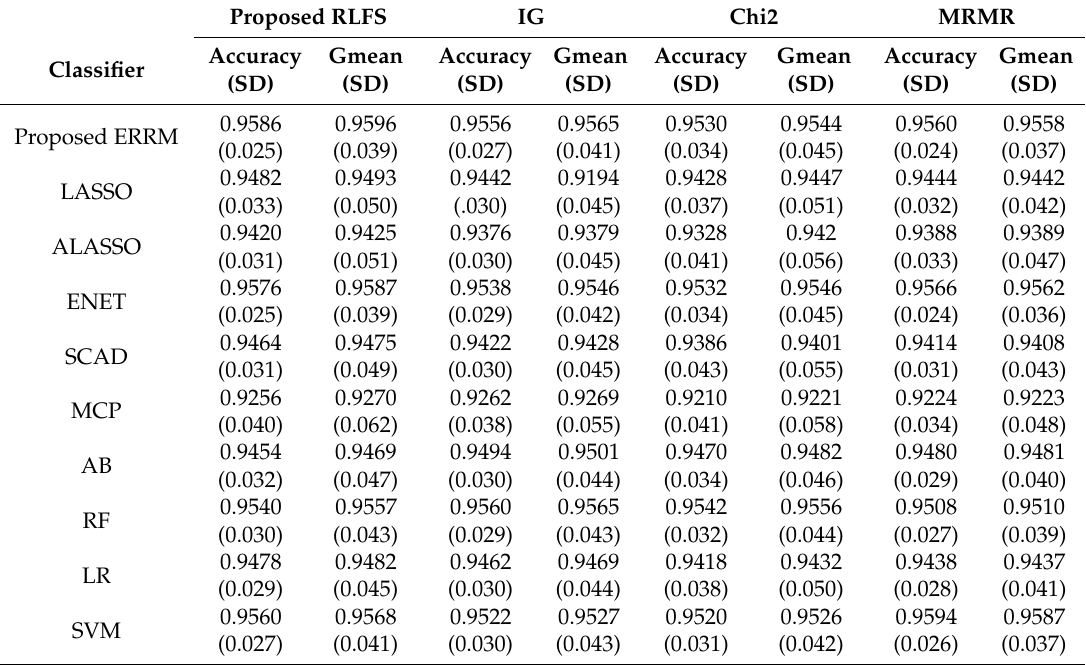
Figure A1. Boxplot showing the accuracies of Classifiers with FS methods in simulation scenario: S3 (Correlation = 0.8). Table A1. Average values taken over 100 iterations in simulation scenario: S3 (High correlation: